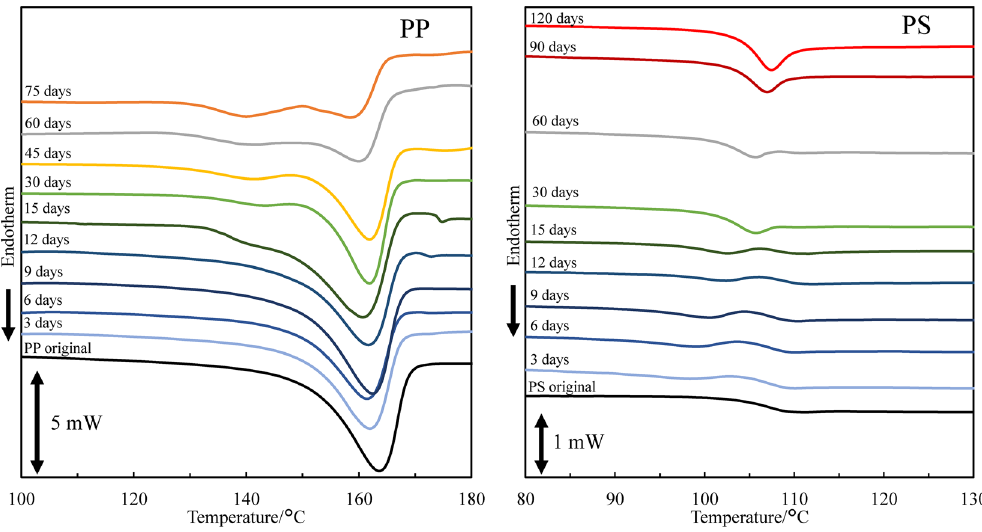
Figure 6. DSC curves of PP and PS samples with various degradation time.